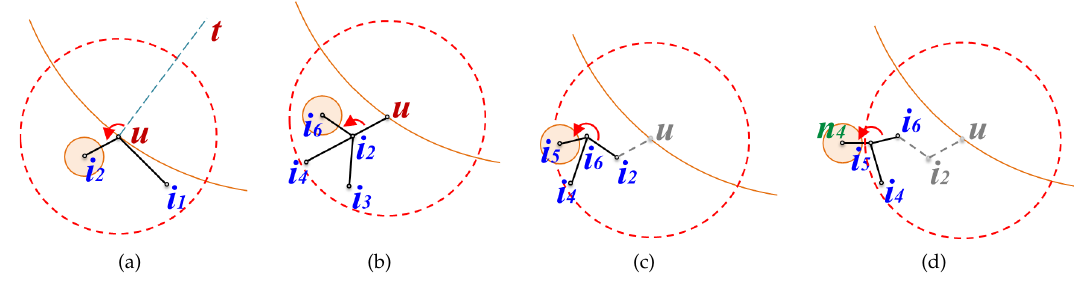
Figure 9. Phases of TEFR node selection: ( a ) the start of simulating face routing, ( b , c ) select the next nodes of nodes i 2 and i 6 , respectively, and ( d ) the termination of node selection. The arc signifies the distance between the destination ( t ) and node u where face routing